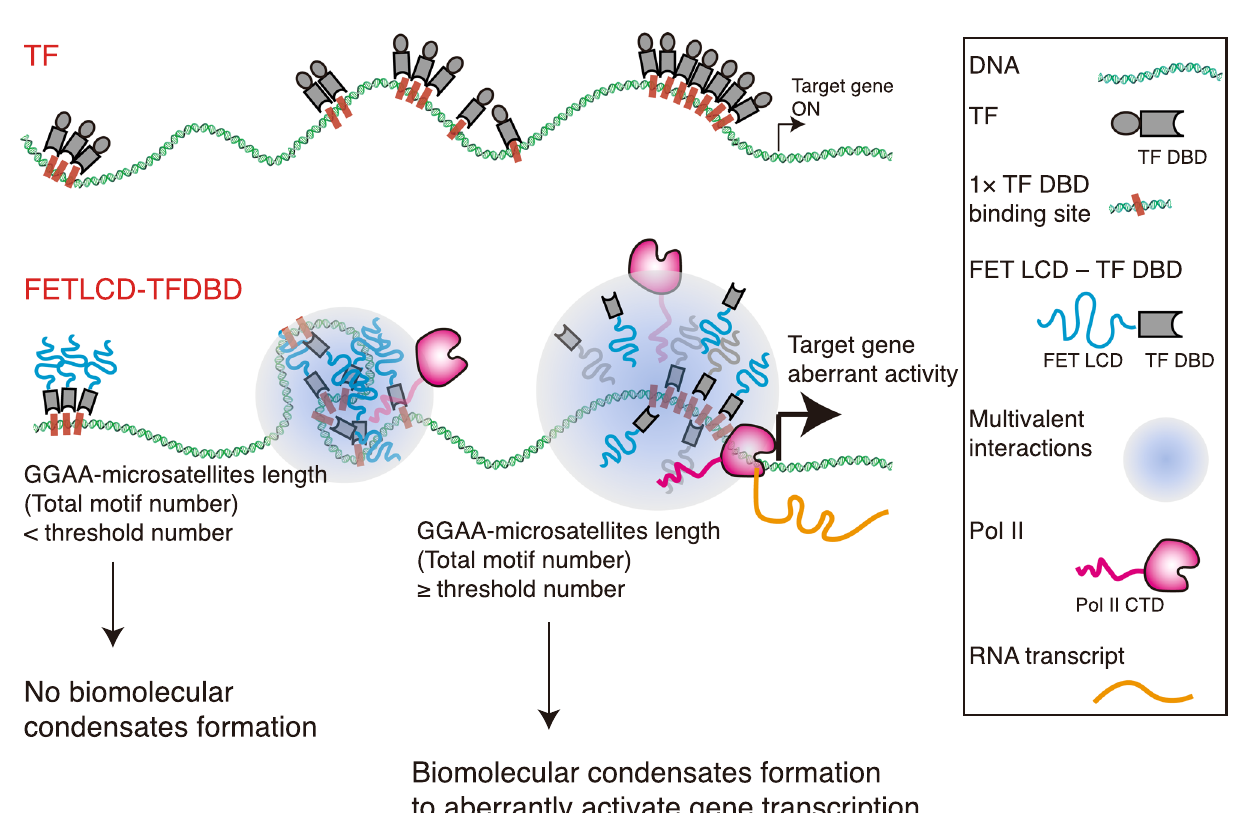
Fig. 6 DNA binding motifs beyond a threshold number drive the formation of FET fusion protein condensates. a Strategy for detecting EWS-FLI1 molecules forming biomolecular condensates on DNA. b (i) A representative wide- fi eld TIRFM image of DNA Curtains was taken 10 min after incubation with 500 nM of mCherry-EWS-FLI1 (top panel). (ii – v) Additional representative wide- fi eld TIRFM images taken at a higher magni fi cation showing the DNA substrate and EWS-FLI1 recruitment. DNA substrates used were Lambda DNA containing 25× GGAA repeats. (vi, vii) Line plot showing the hypothetical distribution of the number of puncta that would be visible if EWS-FLI1 recruitment was driven by a threshold number of consecutive motifs (vi) or total motifs (vii). Puncta are predicted when the number of motifs is equal to or above the threshold number of GGAA motifs as indicated by a dashed red line in respective line plots. Both inserts were the consecutive motif or total motif analysis near the region containing 25× GGAA repeats. c – h Lambda DNA containing 13× GGAA repeats c, 9× GGAA repeats d, 7× GGAA repeats e, 5× GGAA repeats f, 3× GGAA repeats g, and wild-type Lambda DNA h. (i) Same as b (i); (ii) Same as b (vii).